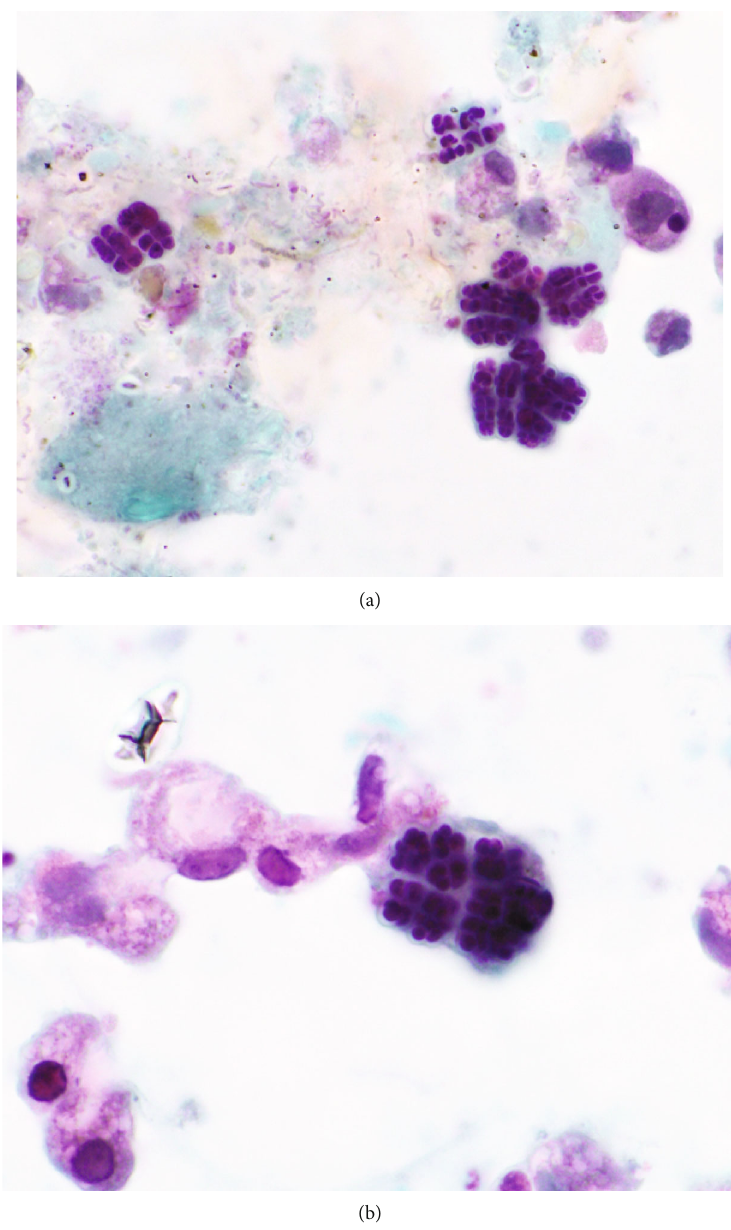
Figure 3: (a) In focal areas of the direct smears, numerous collections of large bacteria arranged in tetrads ( Sarcina ventriculi ) were noted. In addition, scattered smaller cocci and a few bacilli (mixed bacteria) were also identi fi ed in backgrounds with necrosis and poorly preserved nucleated cells (Papanicolaou stain, original magni fi cation 1000X). (b) Highest power magni fi cation depicting clustered Sarcina organisms with adjacent macrophages, noting comparatively clear background without accompanying acute in fl ammation, suggesting carry-through microorganisms from lumen of GI tract (Papanicolaou stain, original magni fi cation